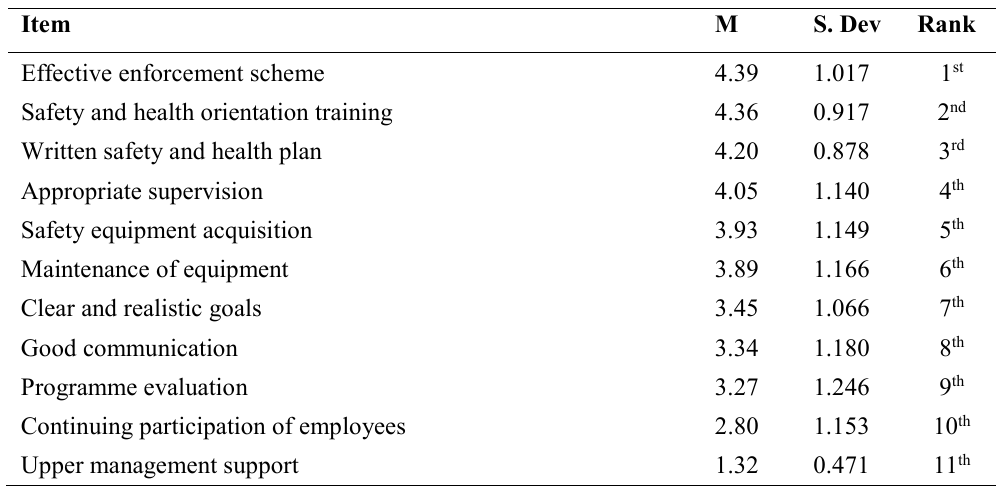
Table 2. Elements of Health and Safety Programmes